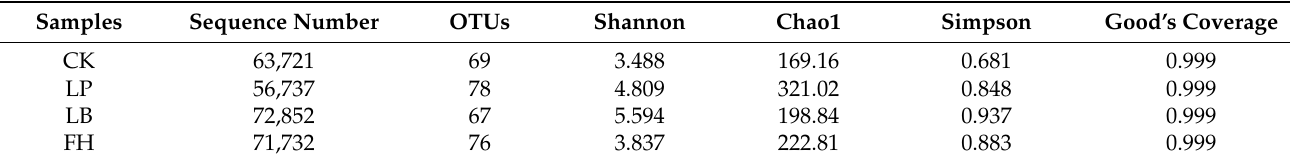
Table 2. Alpha diversity of fungi in M. aquaticum silage after 60 days of